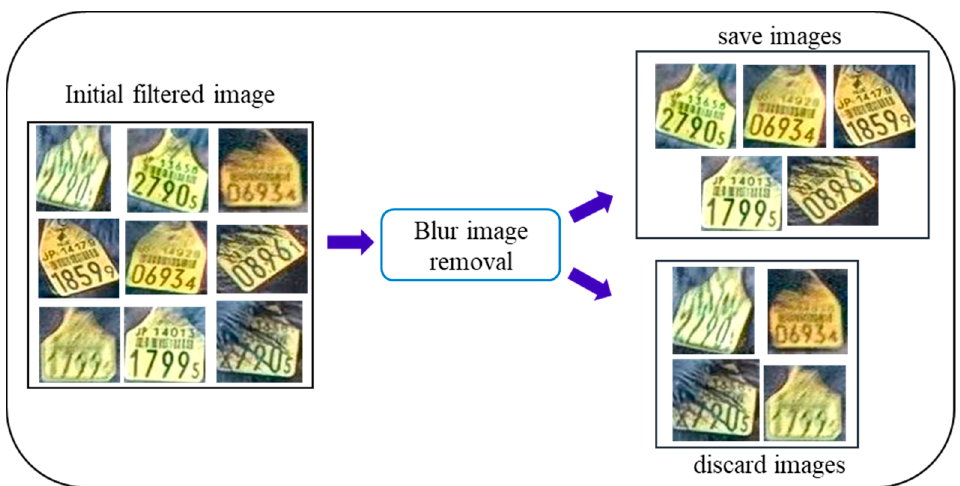
Figure 6. Ear tag Figure 6. Ear tag filtering.